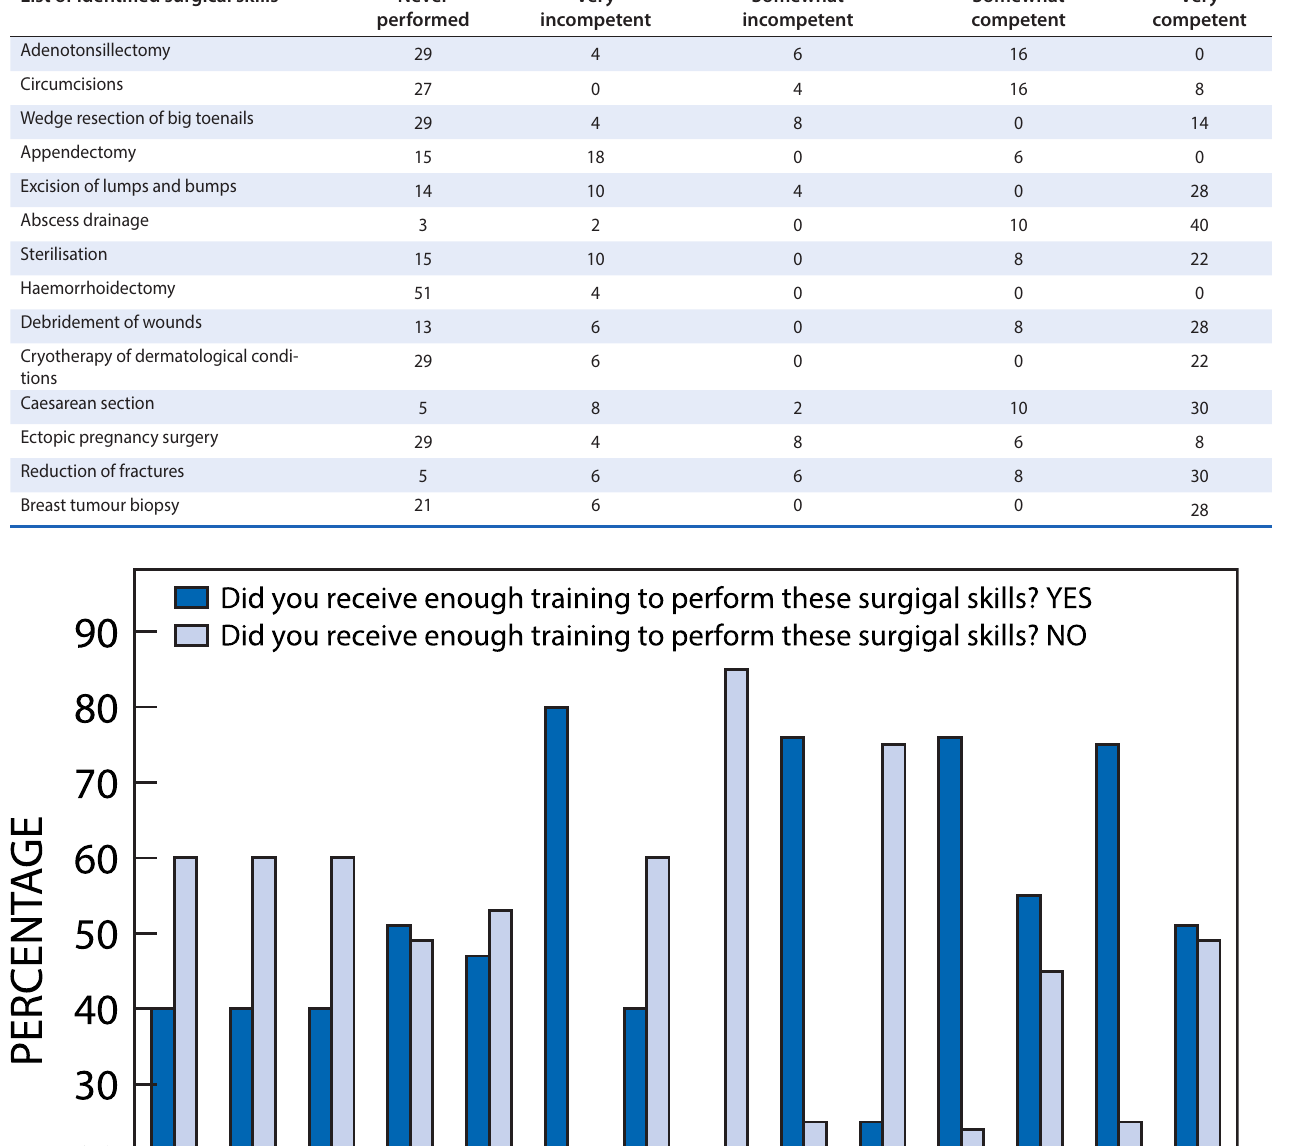
Table 4: Interns’ perceptions on their competence in the identified surgical skills listed List of identified surgical skills